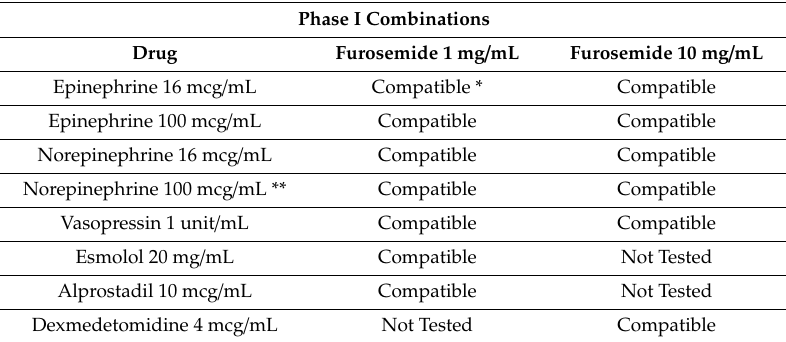
Table 3. Phase I overall physical compatibility results.